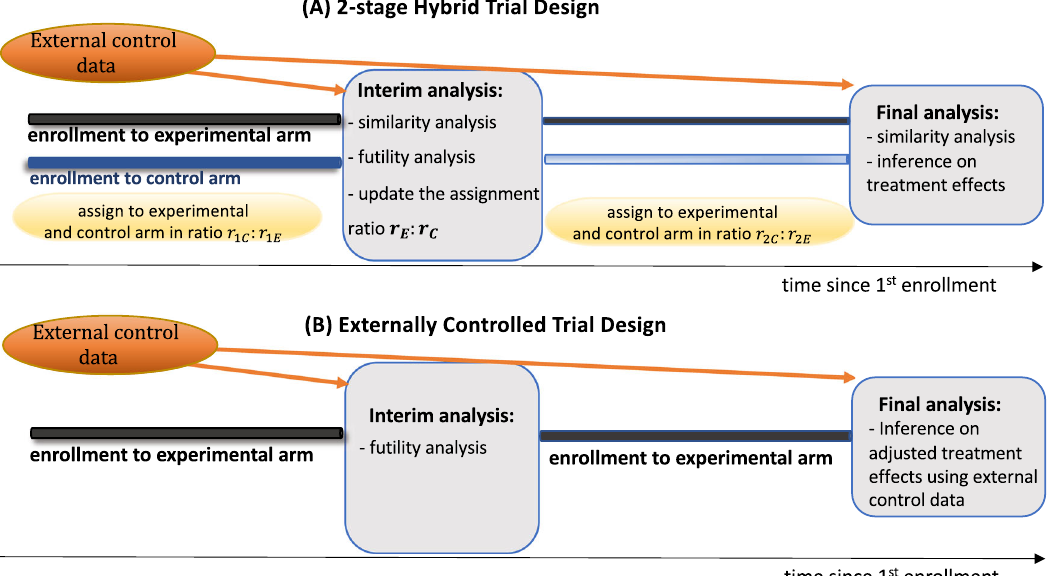
Fig.1|Two-stagehybridtrial(HT)andexternallycontrolledtrial(ECT)designs. Panel ( A ) shows a two-stage HT design, with n 1 and n 2 and enrollments to the internalcontrol(IC)andexperimentalarminratiosr 1E :r 1C andr 2E :r 2C duringthe fi rst and second stages of the study, respectively. An interim analysis (IA) determines if the study is closed for futility or not, and potentially updates the randomization ratio from r 1E :r 1C during the fi rst stage to r 2,C :r 2,E for the second stage of the study. These decisions are supported by an index of dissimilarity (see Methods) between